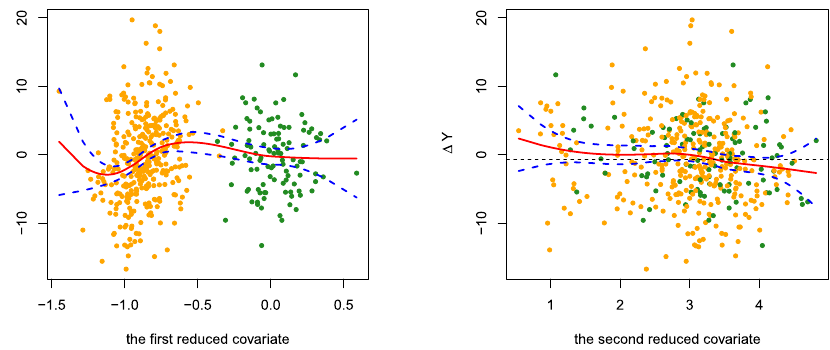
Figure 2: Homeless data with reduced covariates. The left (right) panel is the scatter plot of the imputed Δ Y against the first (second) reduced covariate from the estimated central causal effect subspace. In each plot, the male (female) subjects are marked in